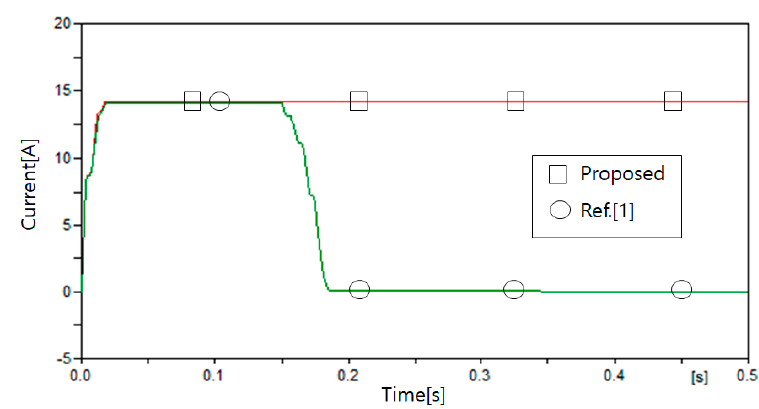
Figure 9. Current measured at Load 3 in Case 1.